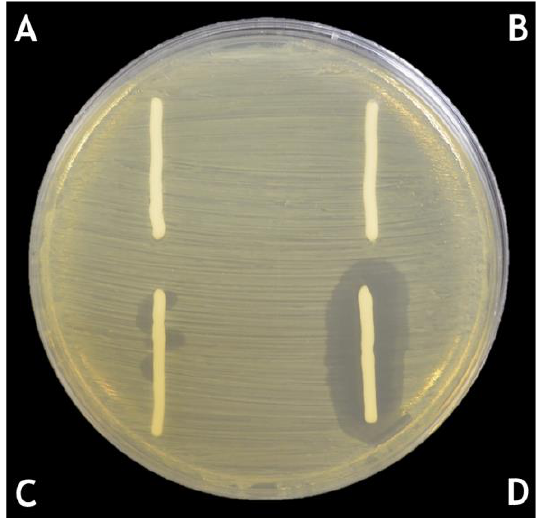
Figure 3. Lytic capacity of the P. acnes phage PAC1 cream formulation. P. acnes phage formulated in cetomacrogol cream aqueous on a lawn of P. acnes bacteria [37]: ( A ) cetomacrogol cream aqueous; ( B ) cetomacrogol cream aqueous with PBS; ( C ) phage cream, PAC1 at a concentration of 5.0 × 10 3 PFU per gram of cream; and ( D ) phage cream, PAC1 at a concentration of 2.5 × 10 8 PFU per gram of cream.